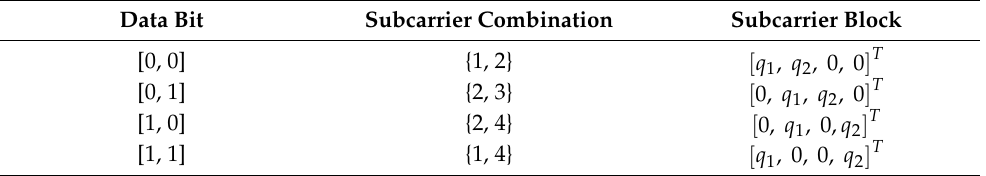
Table 1. The mapping table of the OFDM-IM scheme with N u = 4 and k u = 2. Data